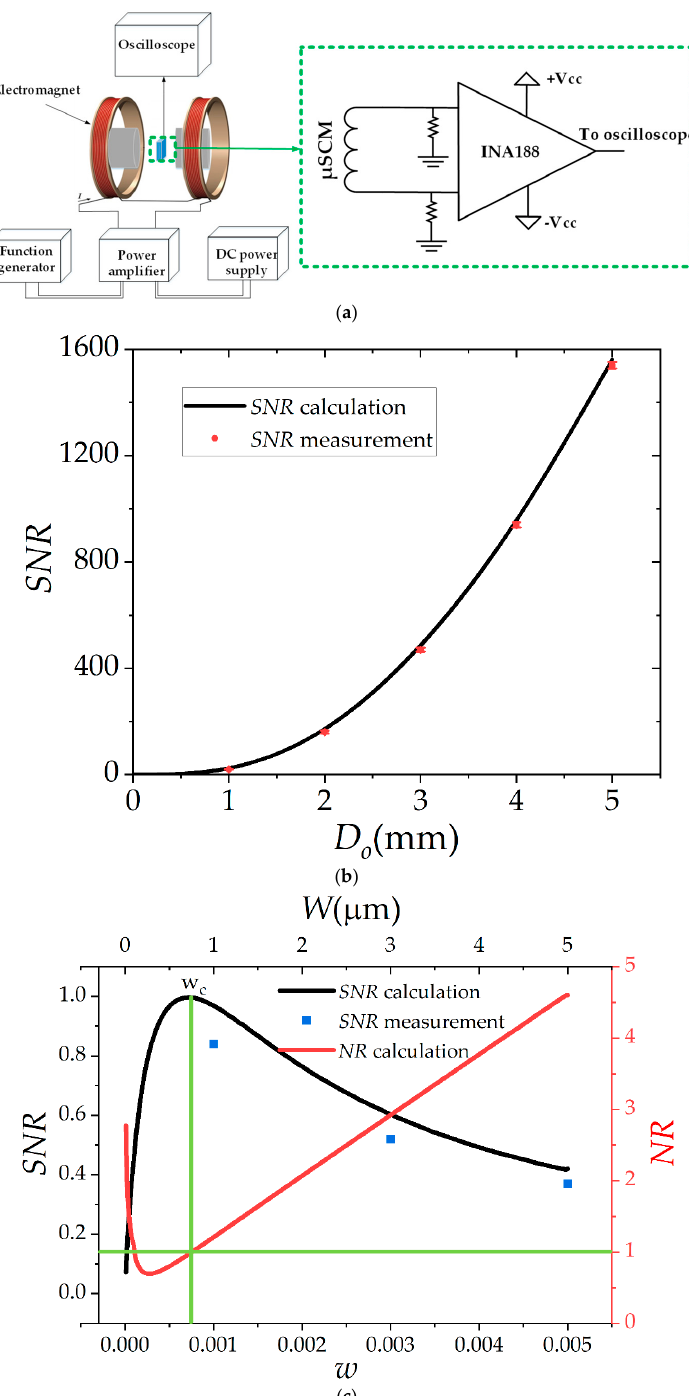
Figure 8. ( a ) The schematic of the measurement setup and the amplifier circuit. ( b ) Comparison between calculation and measurement results for SNR . ( c ) Normalized SNR and noise ratio ( NR = e n-amp / e nR ) as a function of w with the noise parameters of INA188 for three different fabricated samples. All SNR values were normalized to the maximum calculated SNR